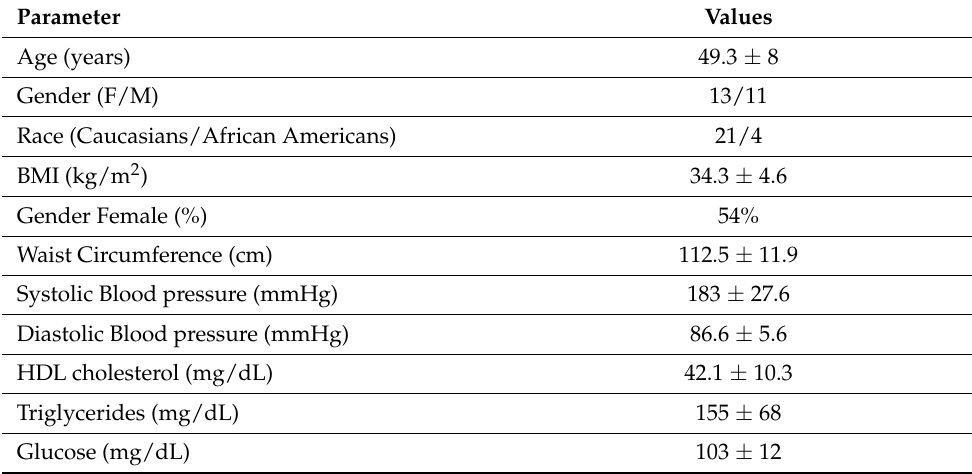
Table 2. Baseline characteristics of participants 1